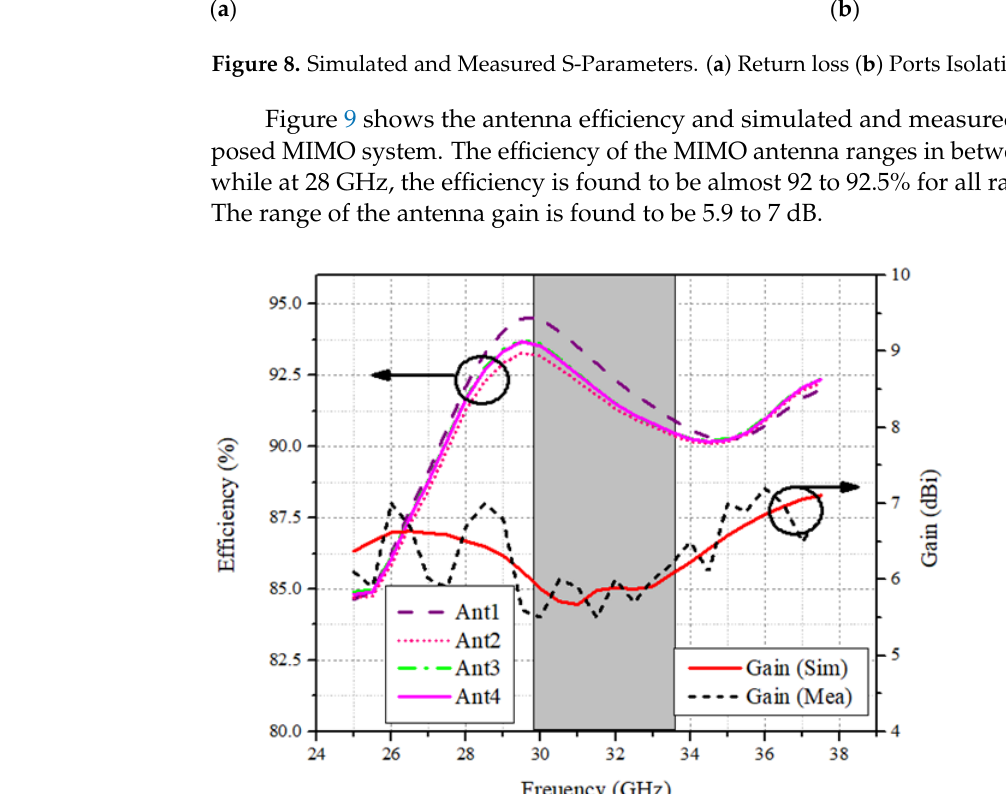
Figure 9. Efficiency and Gain of the MIMO Antenna.